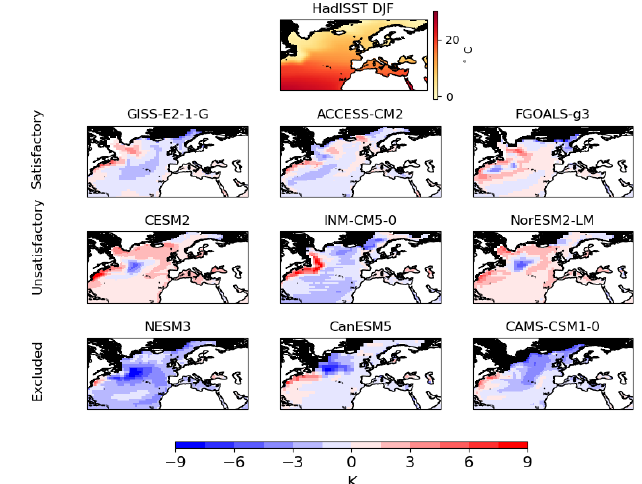
Figure A3. Model SST bias (compared to HadISST) for JJA. Sea- sonal average calculated for a 20-year climatology (1995–2014). Areas where the model SST < 0 ◦ C are masked in black (this was found to approximate 5% ice concentration). Top row shows the HadISST and 5% ice concentration